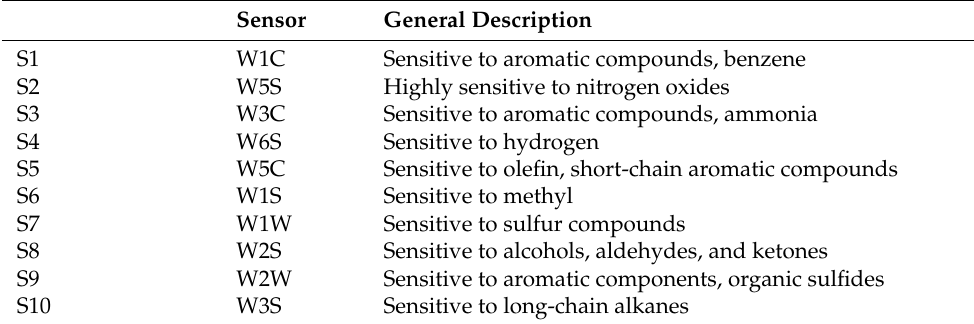
Table A1. The sensor array of the E-nose.